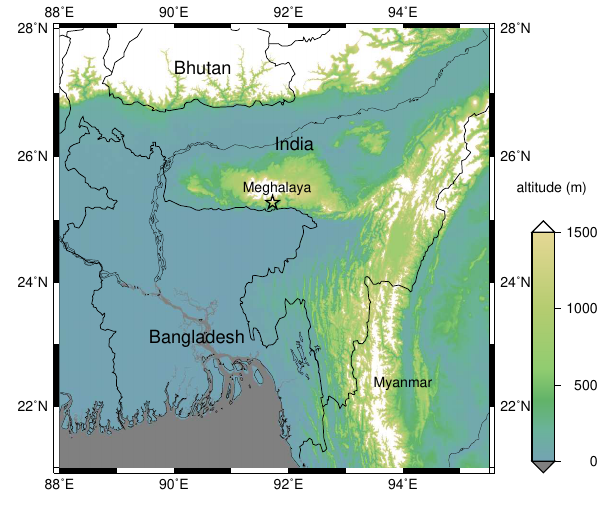
Figure 1. Topography over northeast India (unit: m) and location of Cherrapunji town (91.72 ◦ E, 25.27 ◦ N, 1313 m MSL) indicated by a